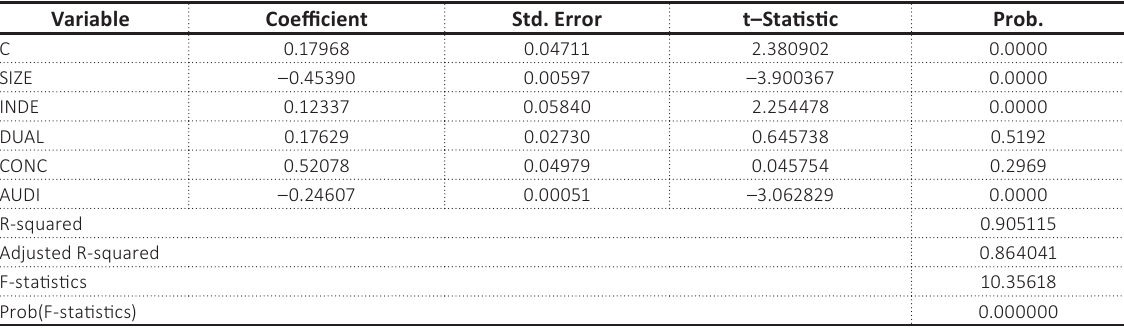
Table 3. Regression